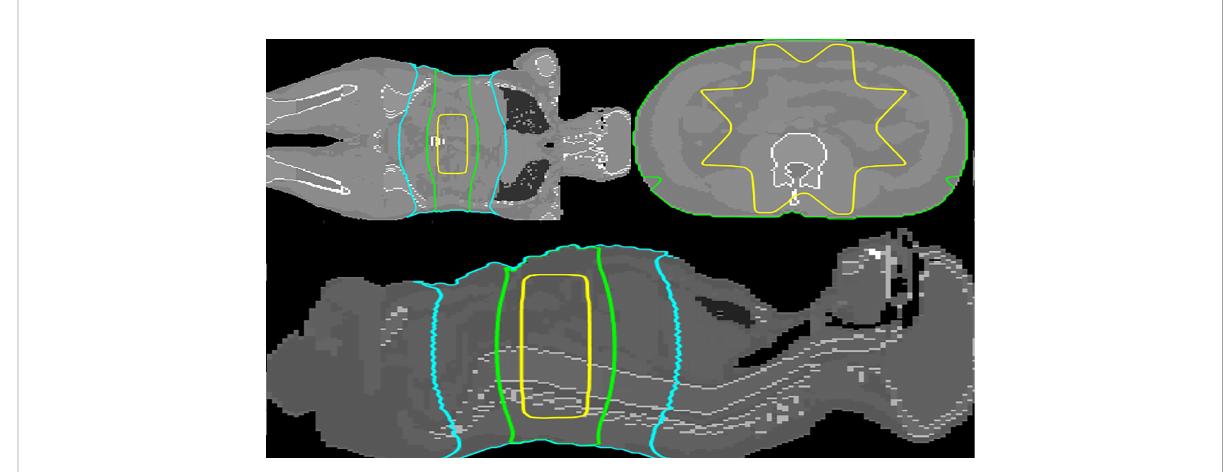
FIGURE 2 Transversal, coronal and sagittal views at the level of the isocenter (mid-abdomen). The 50%, 5%, and 1% isodoses are depicted in yellow, green, and cyan, respectively. The dose distribution was calculated by MC simulation.